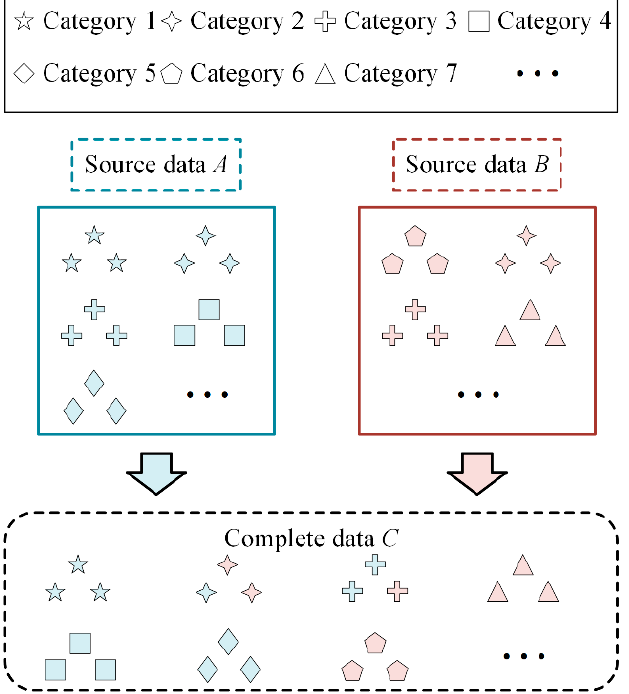
Figure 4. The process of forming a complete dataset C. After the weak classifier C W is obtained, the test samples from the target